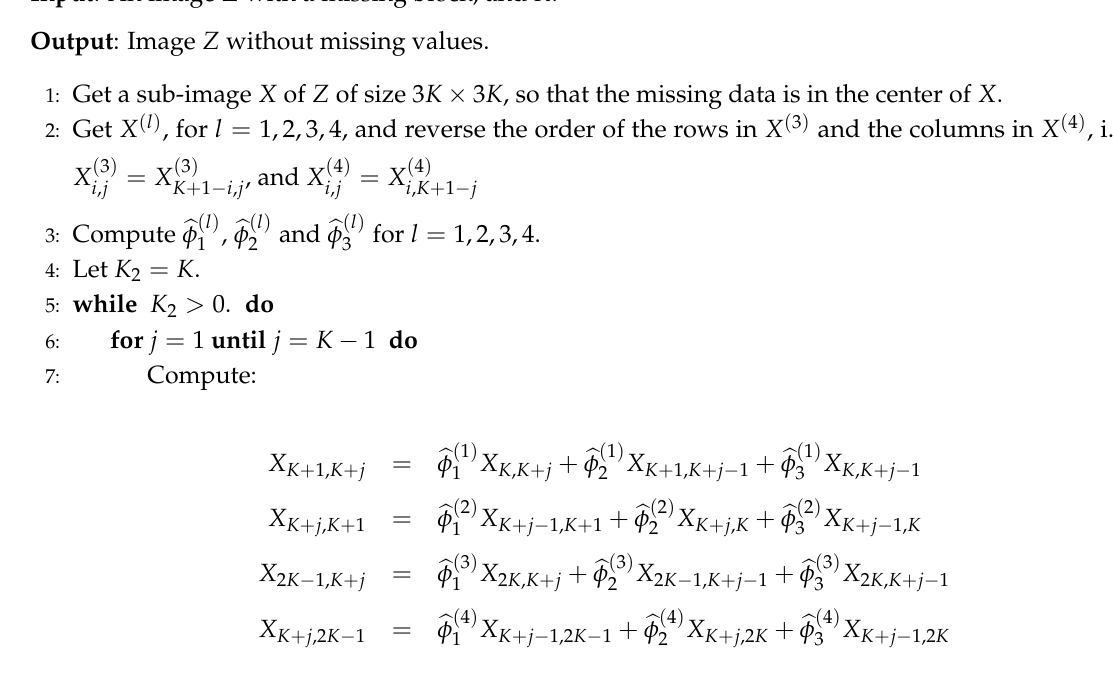
Algorithm 2 Prediction